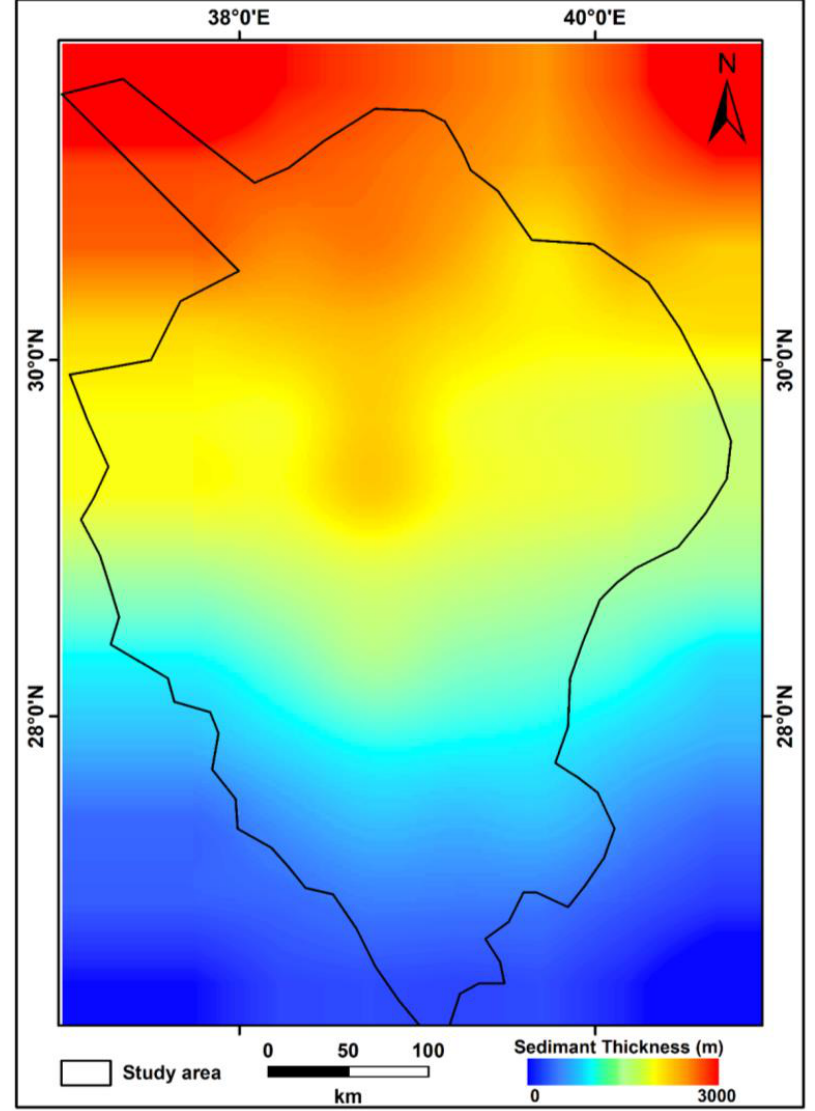
Figure 9. Thickness of the sedimentary cover